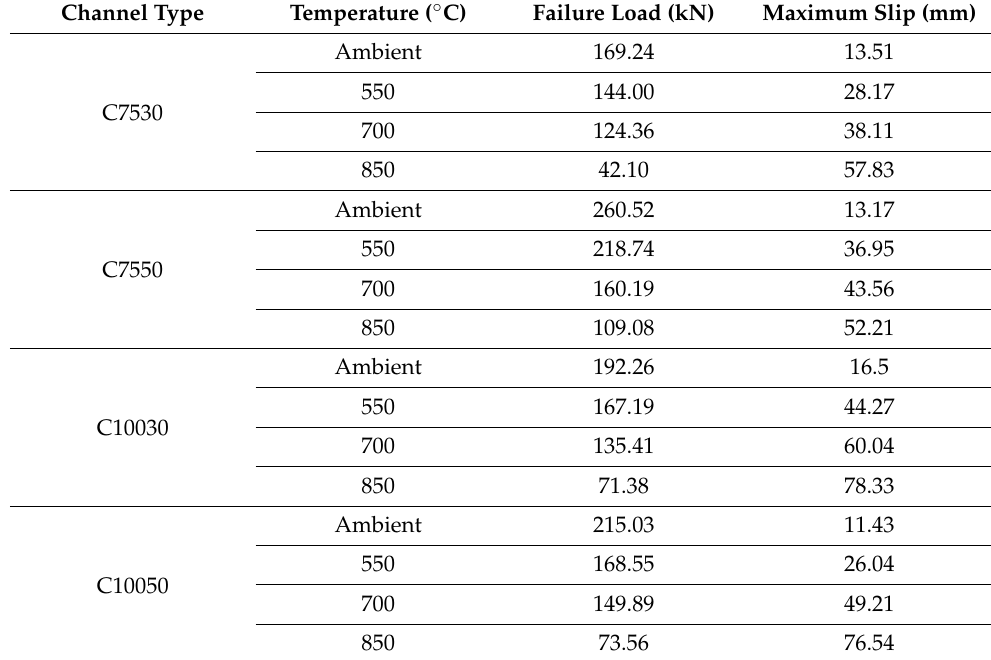
Table 2. FE analysis results.